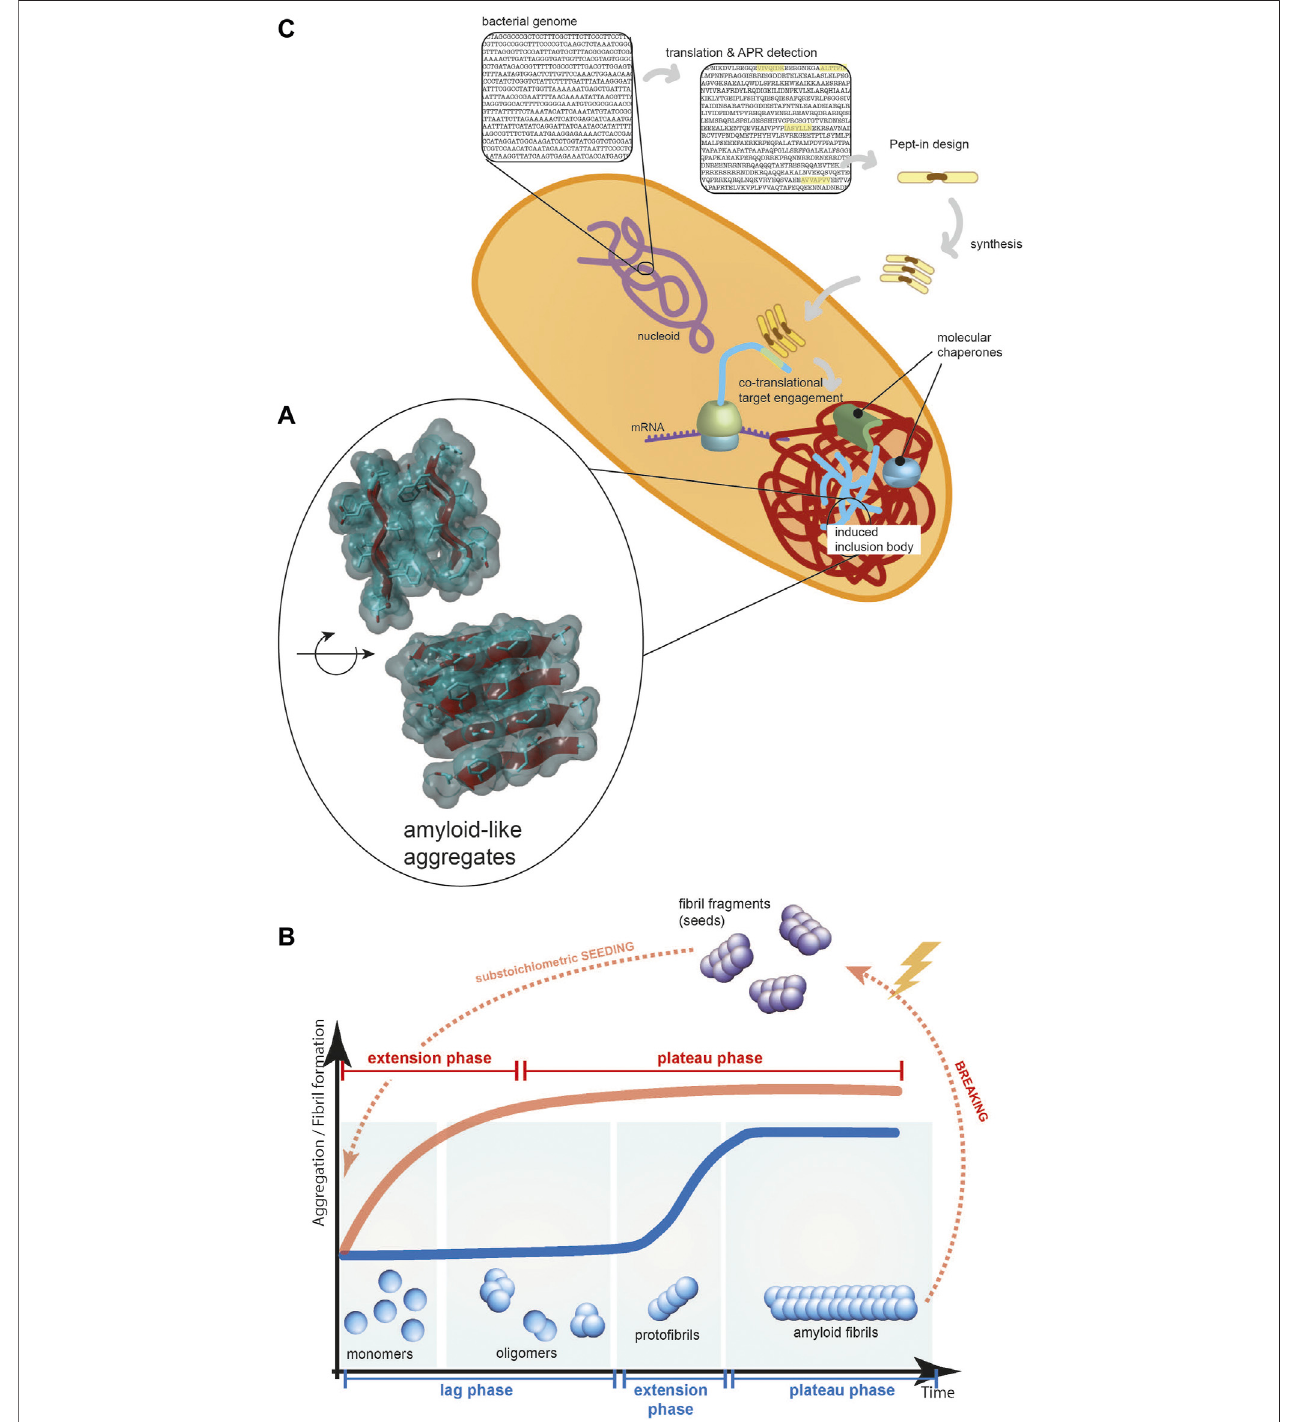
FIGURE 1| (A) The core ofprotein aggregates contains beta-strandsforming beta-sheets held together by hydrogen bonds between the polypeptide backbones and these beta-sheets can pack in layers via interdigitating amino acid sidechains. (B) The typical kinetics of amyloid-like protein aggregation (blue line): a rate-limiting nucleationphase,afast-growingelongationphase,anda fi nalplateauphase.Seedingthereactionwithsubstoichiometricamountof fi brilfragmentscaneliminatethelag phase (red line). (C) Pept-ins are designed based on detecting APRs in the translated bacterial genome. They seem to form small seeds (depicted as stacks of Pept-ins in the Figure) that induce the fast co-translational aggregation of proteins and the formation of inclusion bodies.